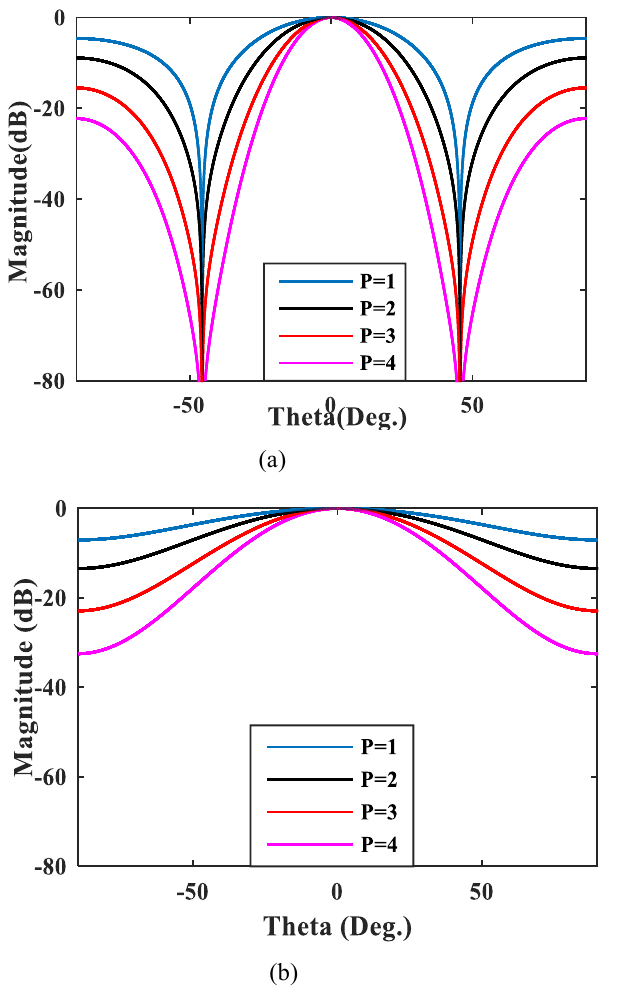
Figure 4. Array factors of linear fractal array antennas generated by concentric (a) elliptical and (b) circular ring sub array generators for S=1 up to four iterations.